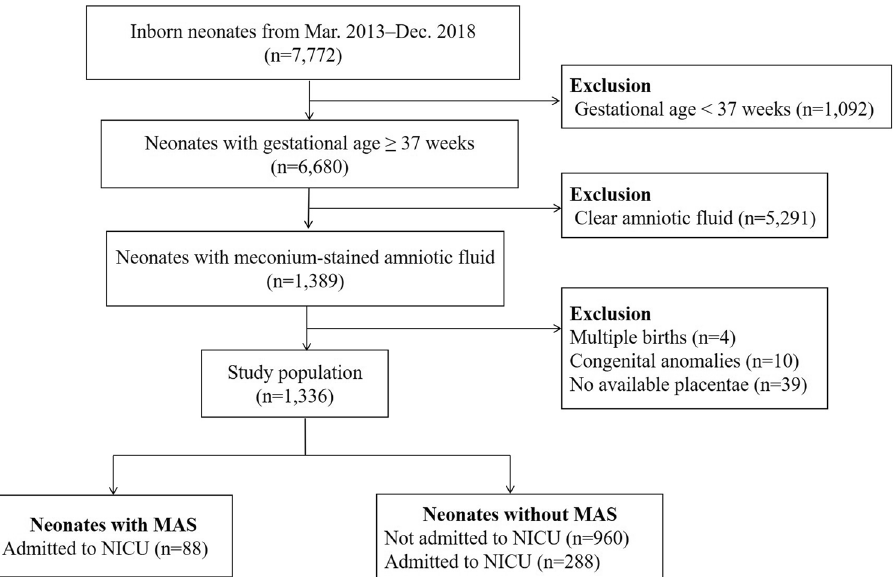
Figure 1. Profile of the study population. MAS meconium aspiration syndrome, NICU Neonatal Intensive Care